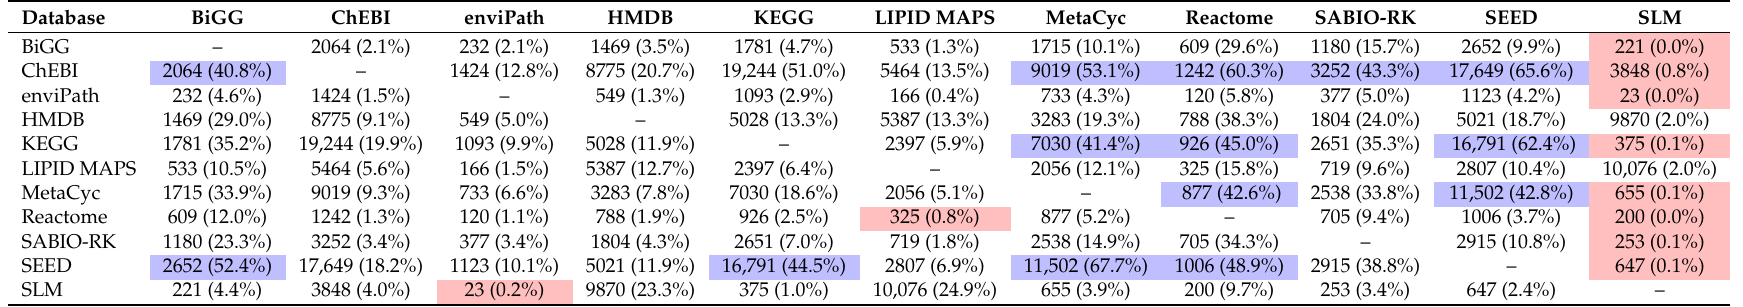
Table 7. Number of IDs in one database (column) that map to IDs in the database in the corresponding row using MetaNetX as a bridge. Percentages indicate fraction of IDs in the initial database. Blue boxes are used to highlight highest numbers, while red boxes indicate lowest numbers.